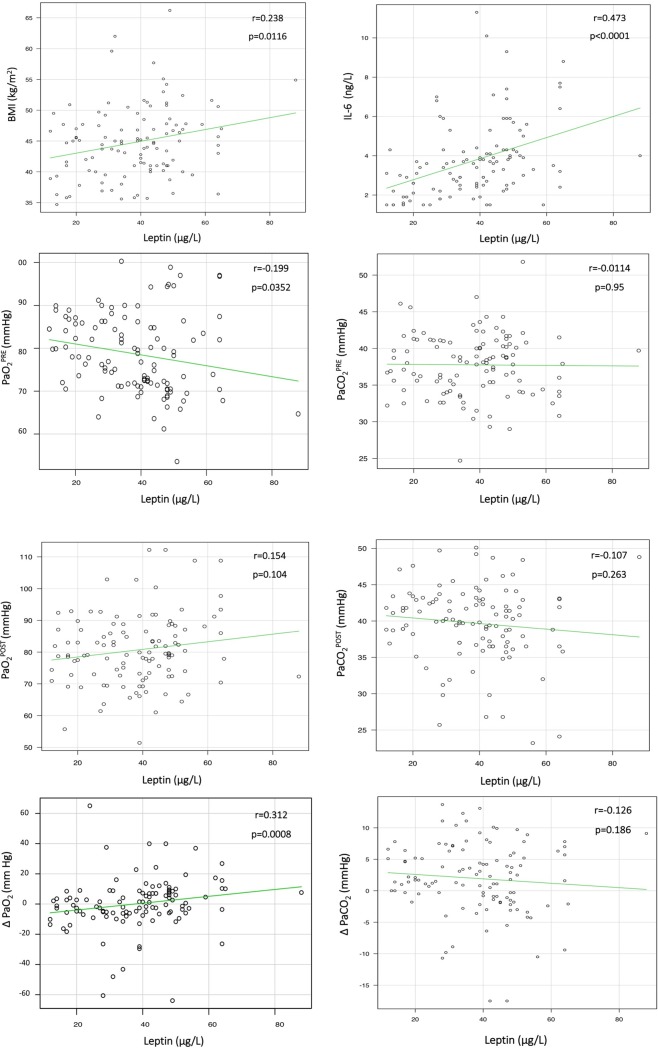
Correlation between serum leptin and other variables.As shown, leptin was positively correlated with BMI, serum IL-6, PaO2POST, and ΔPaO2 and negatively correlated with PaO2PRE, PaCO2PRE, PaCO2POST, and ΔPaCO2. BMI, body mass index; IL-6, interleukin 6; PaCO2POST, postoperative arterial partial pressure of carbon dioxide (PaCO2); PaCO2PRE, preoperative PaCO2; ΔPaCO2, PaCO2POST minus PaCO2PRE; PaO2POST, postoperative arterial partial pressure of oxygen (PaO2); PaO2PRE, preoperative PaO2; ΔPaO2, PaO2POST minus PaO2PRE; r, Bravais-Pearson correlation coefficient.